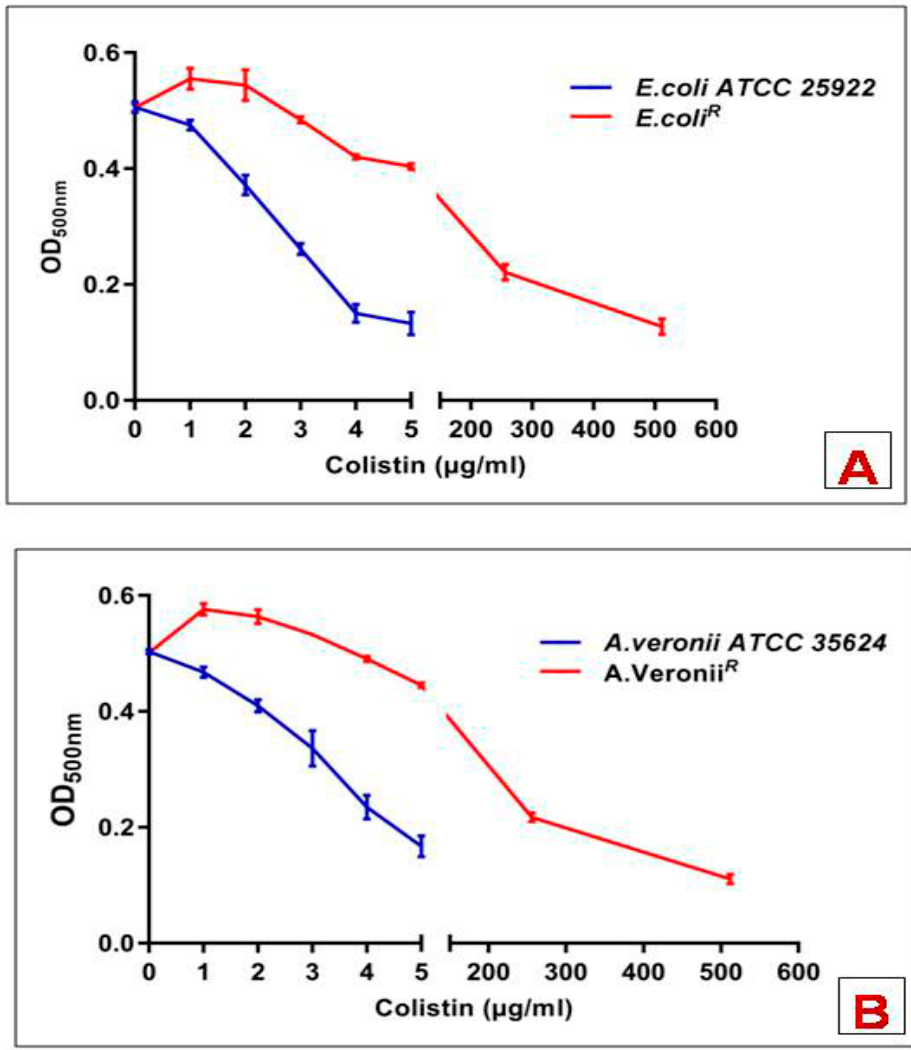
Figure 1. Deoxycholate-induced cell lysis of bacterial strains in response to increasing concentrations of colistin ( A ) E. coli ; ( B ) A. veronii. Data points are the mean ± SD of three independent measurements.